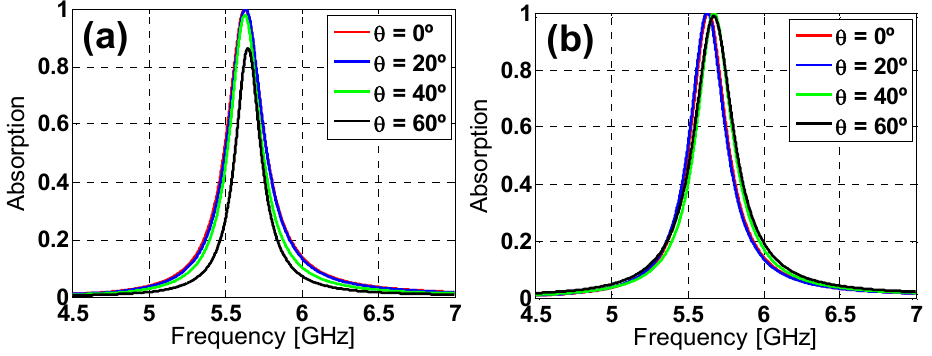
Figure 6. Starting design absorption simulation results under different incident angles ( θ ) for both ( a ) TE and ( b ) TM polarizations.